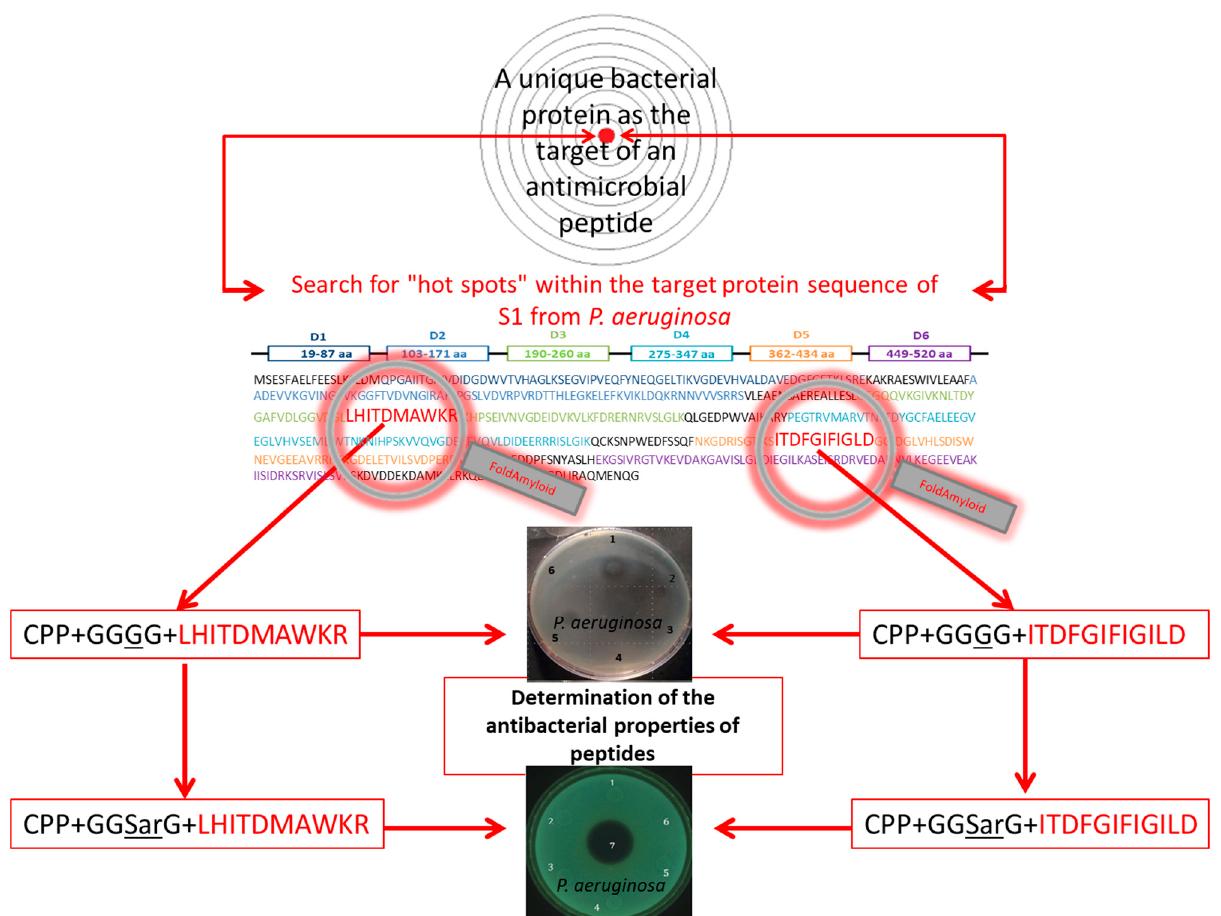
Figure 1. Schematic diagram of the creation of new AMPs (against P. aeruginosa ) based on targeted protein aggregation. The domain organization of the S1 protein is shown schematically, each of the six protein domains (D1–D6) is color represented. The red font shows two amyloidogenic regions: LHITDMAWKR from the third domain and ITDFGIFIGLD from the fifth domain predicted by the FoldAmyloid and AGGRESCAN programs within the ribosomal S1 protein from P. aeruginosa [51]. The N-terminus of synthesized hybrid peptides contains a cell penetrating peptide (CPP) fragment RKKRRQRRR connected to the amyloidogenic region using a linker of four glycine residues (GGGG) or three glycine and sarcosine residues (GG-Sar-G). The hybrid AMPs with different concentrations can be tested against P. aeruginosa strains (see below “Materials and Methods” section).